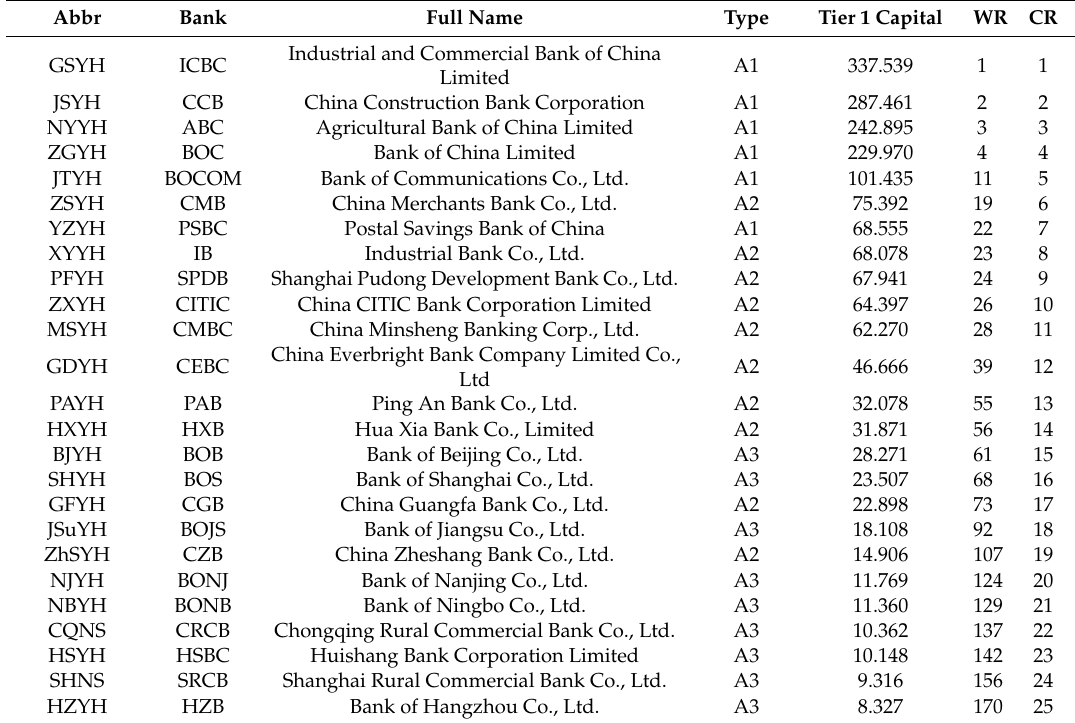
Table 1. The world rankings of China’s Top 25 banks 1 .